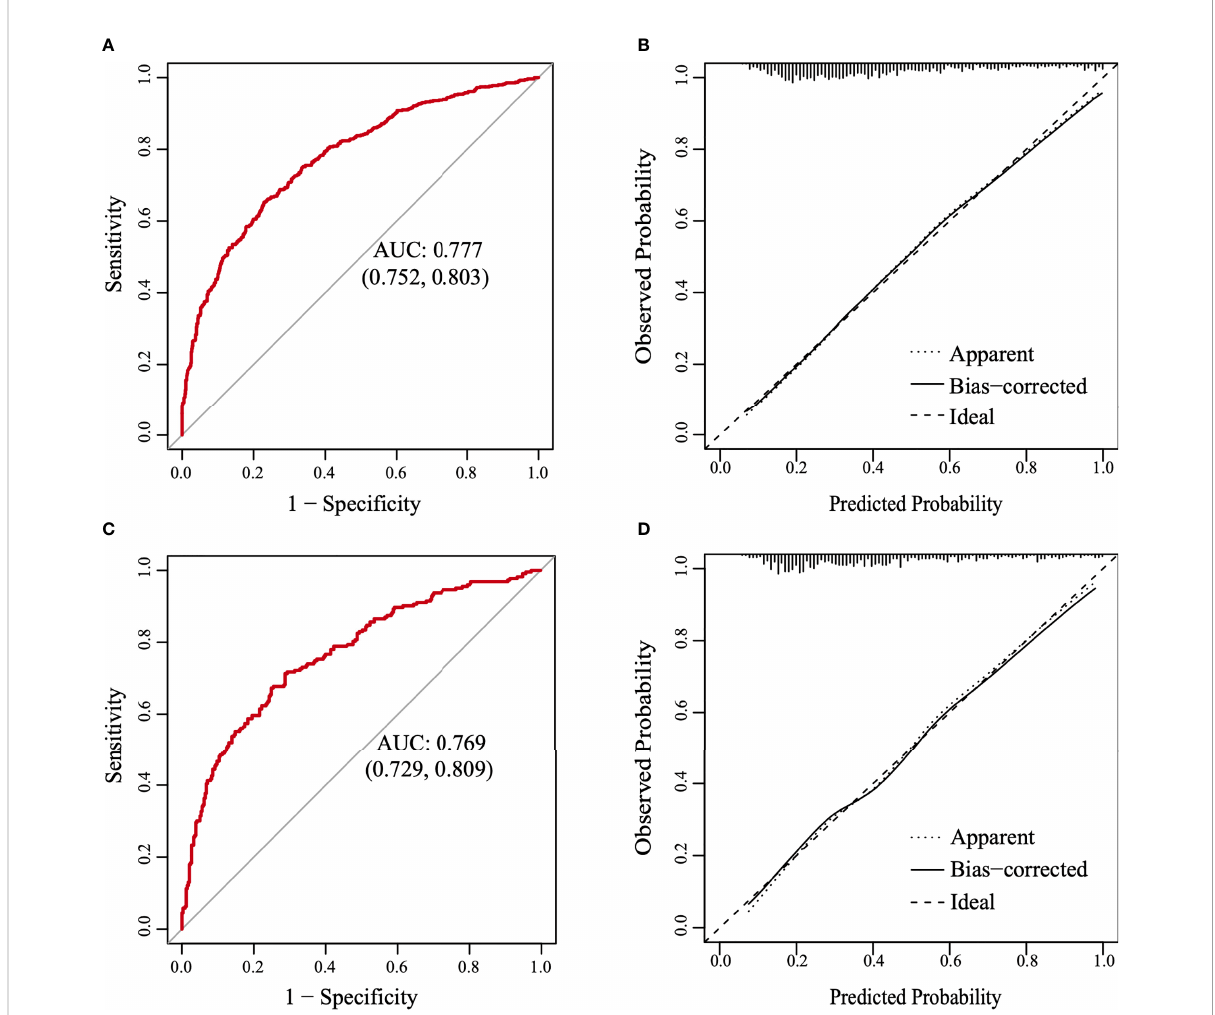
FIGURE 4 The receiver operating characteristic (ROC) curve and the calibration curve. (A) The ROC curve in the training set. (B) The calibration curve in the training set. (C) The ROC curve in the validation set. (D) The calibration curve in the validation set.